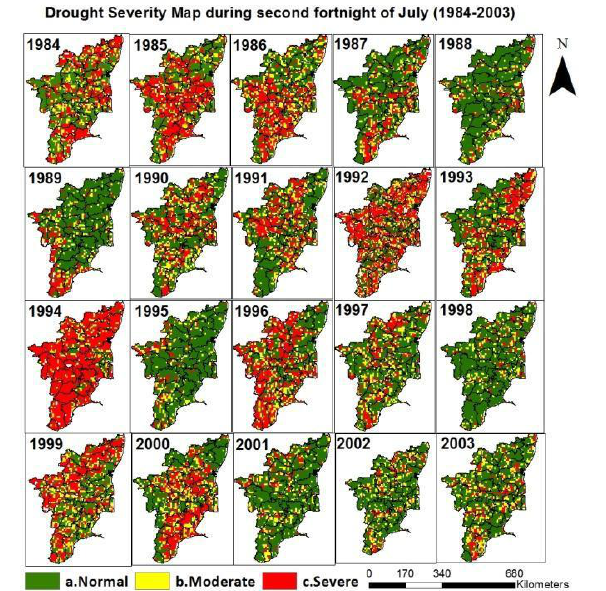
Figure 5 Drought intensity maps for 20 years during July 2nd fortnight A keen observation of the drought intensity maps reveal that